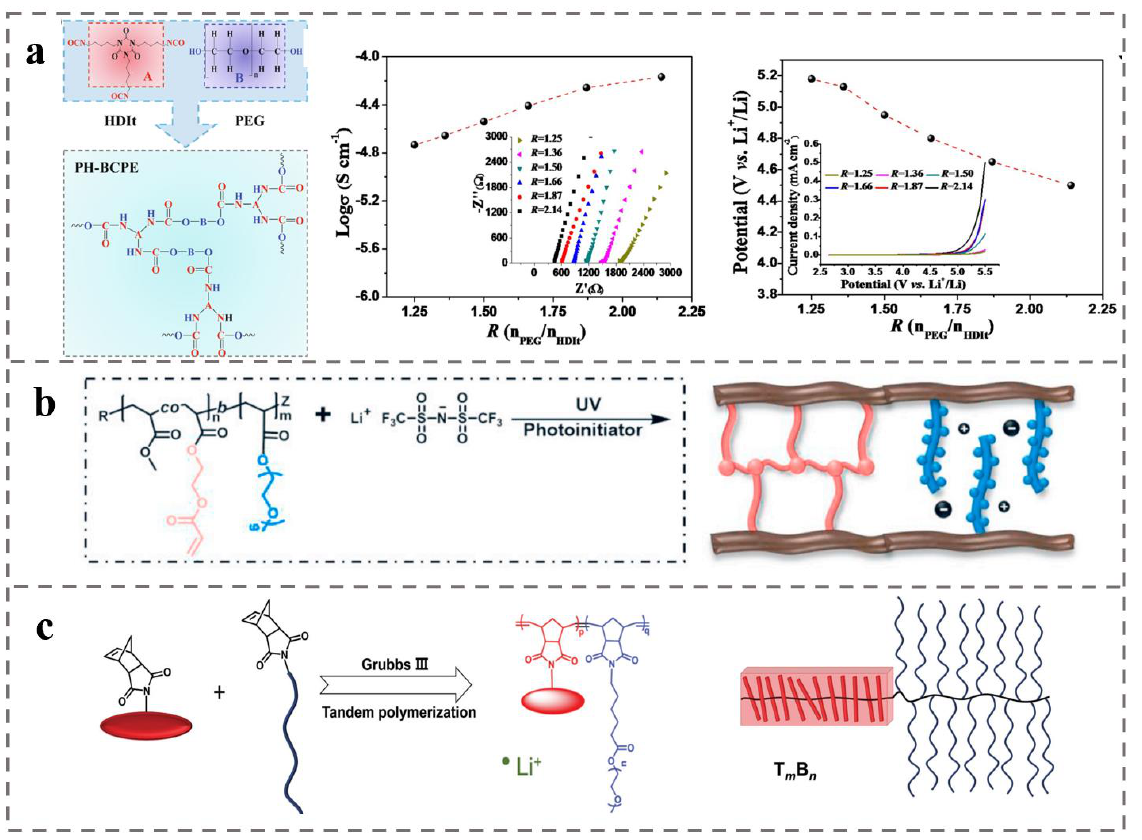
Figure 12. ( a ) PEG and HDIt molecules were copolymerized to obtain PH-BCPE with 3D network structure. R has a decisive effect on the ionic conductivity and electrochemical window of PH-BCPE [231]. ( b ) Synthesis of P(DBEA-co-MA)-b-PEG with 3D cross-linked network structure [232]. ( c ) TB-BCPEs were synthesized by tandem polymerization and have a lamellar structure favorable for ion transport